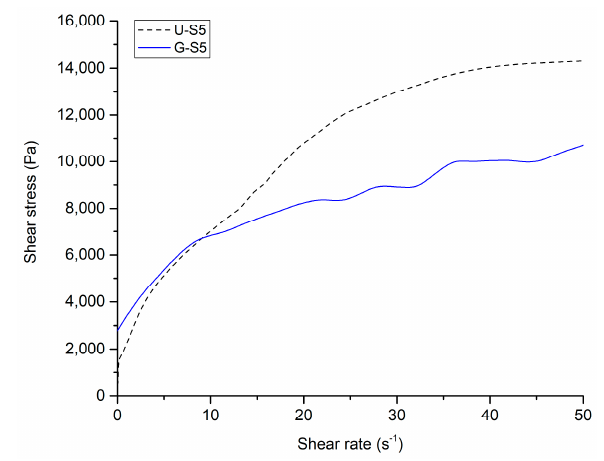
Figure 7. Comparison between the flow curves of the formulations G-S5 and U-S5.